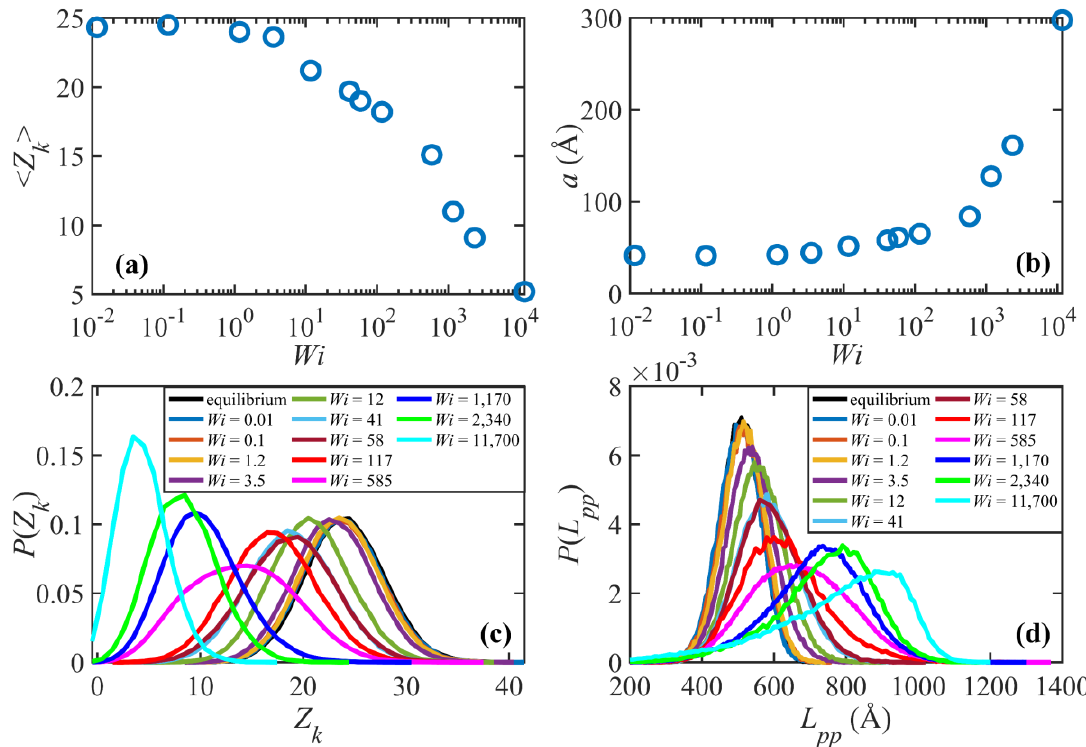
Figure 5. Average number of entanglements per chain versus Wi ( a ), the effective tube diameter versus Wi ( b ), and probability distributions of the number of entaglements per chain ( c ) and the primitive path contour length ( d ) at various values of Wi